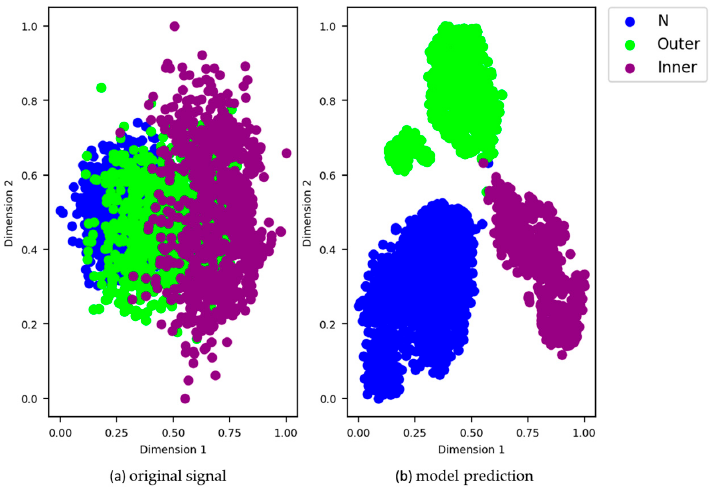
Figure 16. t-SNE representations of the MFPT testing samples: ( a ) original signal and ( b ) model prediction.